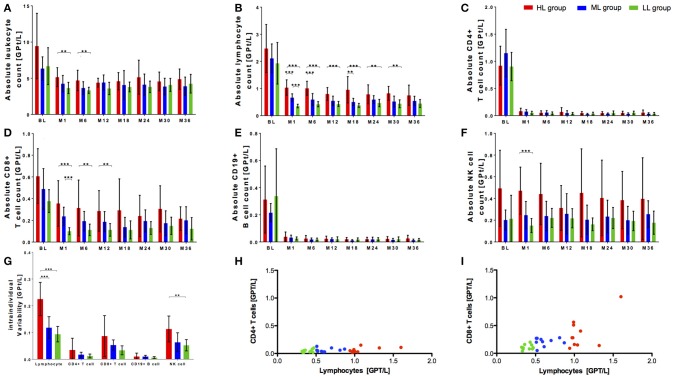
Cell count of selective immune cell subpopulations in cohorts with different initial lymphocyte decrease after fingolimod start. Absolute cell count of leukocytes (A), lymphocytes (B), CD4+ T cells (C), CD8+ T cells (D), CD19+ B cells (E), and NK cells (F) are depicted. Three groups of patients during fingolimod treatments are compared: HL group (high lymphocyte count 1 ≥ 1.0 GPt/L, red) ML group (medium lymphocyte count 0.5–1.0 GPt/L, blue) and LL group (low lymphocyte count ≤ 0.5 GPt/L, green). BL, month 1 and 6 months interval of evaluation up to 36 months of fingolimod therapy are depicted. (G) Intra-individual variability of lymphocytes, CD4+ T cells and CD8+ T cells, CD19+ B cells and NK cells compared between HL group, ML group and LL group are presented. Intra-individual variability was declared as the standard deviation of absolute cell counts between month 1 to month 36 of fingolimod therapy. Mean ± SD are depicted. Asterisks indicate level of significance of pairwise comparison. (**p < 0.01 and ***p < 0.001) (H,I) Correlation of decrease of CD4+ T cells resp. CD8+ T cells and lymphocytes are presented. Mean of absolute lymphocyte count, CD4+ T cell count and CD8+ T cell count between month 1, month 3, and month 6 after fingolimod start were calculated and depicted. Level of statistical significance was evaluated using Spearman's correlation. (H)
r = 0.2849, n.s. (I)
r = 0.5998, p < 0.001.